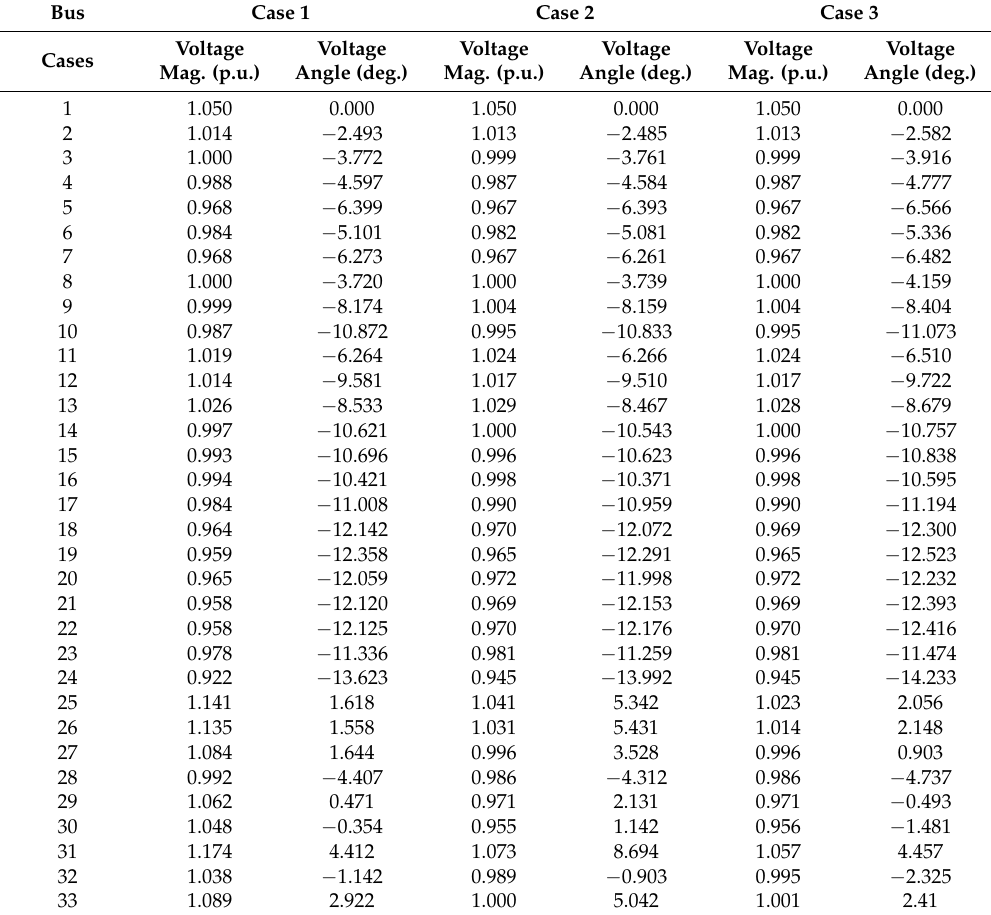
Table A1. Power flow results of three